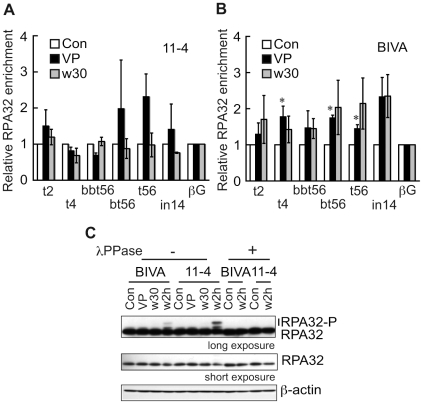
RPA is loaded on the BCR after etoposide treatment.(A, B) ChIP analysis after etoposide treatment of 11-4 (A) and AT5BIVA (B) cells using antibodies against RPA was performed as described in Figure 3. Values represent the means ± SE from three independent experiments. *P<0.05 (compare to βG by Student's t test). (C) Immunoblotting analysis of AT5BIVA and 11-4 cells using anti-RPA32 antibodies. Cells were treated with etoposide for 10 min (VP) and allowed to recover in normal medium for 30 min (w30) or 2 hours (w2h). Slower migrating bands, indicated as RPA32-P, in the long exposed blot were lost by λ-phosphatase (λPPase) treatment. β-actin was used as a loading control.